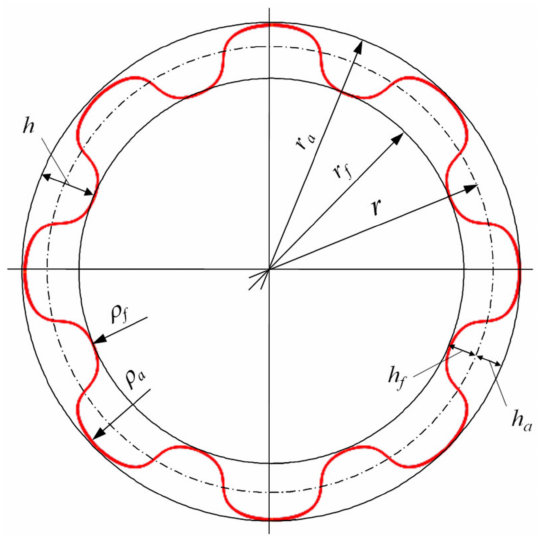
Figure 3. Geometry of the M-T04 family for n = 8 (exemplary)